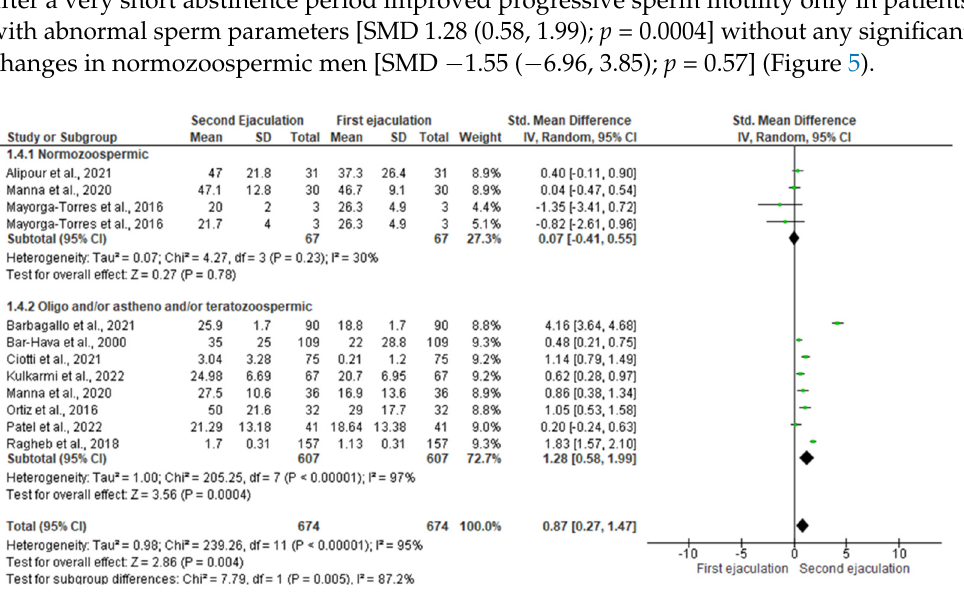
Figure 5. Forest plot of studies that evaluated the effects of a very short abstinence period on progressive sperm motility (expressed as a percentage). The following studies were included in the quantitative analysis (in order of appearance in the manuscript): Manna et al., 2020 [16], Ortiz et al., 2016 [18], Ragheb et al., 2018 [20], Ciotti et al., 2021 [22], Bar-Hava et al., 2000 [29], Mayorga-Torres et al., 2016 [32], Alipour et al., 2021 [34], Barbagallo et al., 2021 [35], Kulkarmi et al., 2022 [36], and Patel et al., 2022 [37].